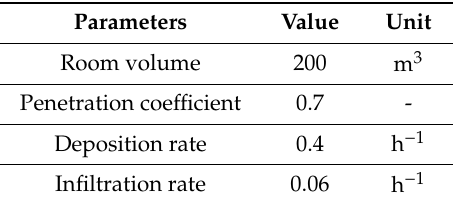
Table 5. Parameters associated with the space.